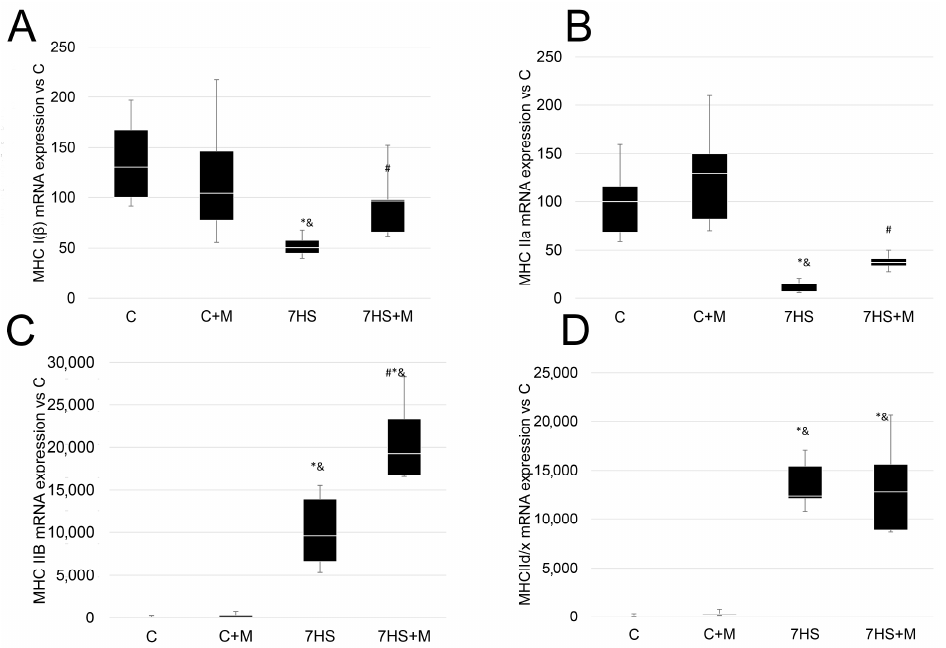
Figure 3. Expression of MyHC I( β ) ( A ), MyHC IIa ( B ), MyHC IIb ( C ), and MyHC IId/x ( D ) mRNAs in rat soleus muscle in the control group (C), control group with metformin (C+M), 7-day hindlimb-suspended group (7HS), and 7-day hindlimb-suspended group with metformin (7HS+M). Data are shown as % of the control group, and median of the C group has been arbitrarily set to 100%. *—significant difference from the control group. &—significant difference from C+M group. #—significant difference from 7HS group ( p < 0.05). Box plots show 25–75 percentiles and median values and the whiskers represent the minimum and the maximum; n = 8/group.